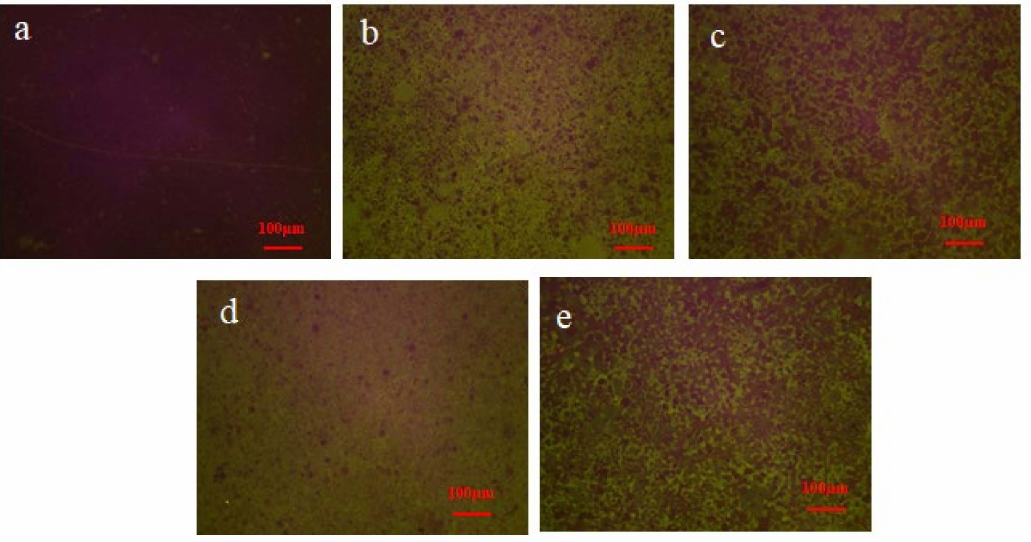
Figure 9. Pictures of WEREA fluorescence microscope with different OEO contents. (( a ) Emulsified asphalt, ( b ) WEAO-4, ( c ) WEAO-5, ( d ) WEAO-6, ( e ) WEAO-7).